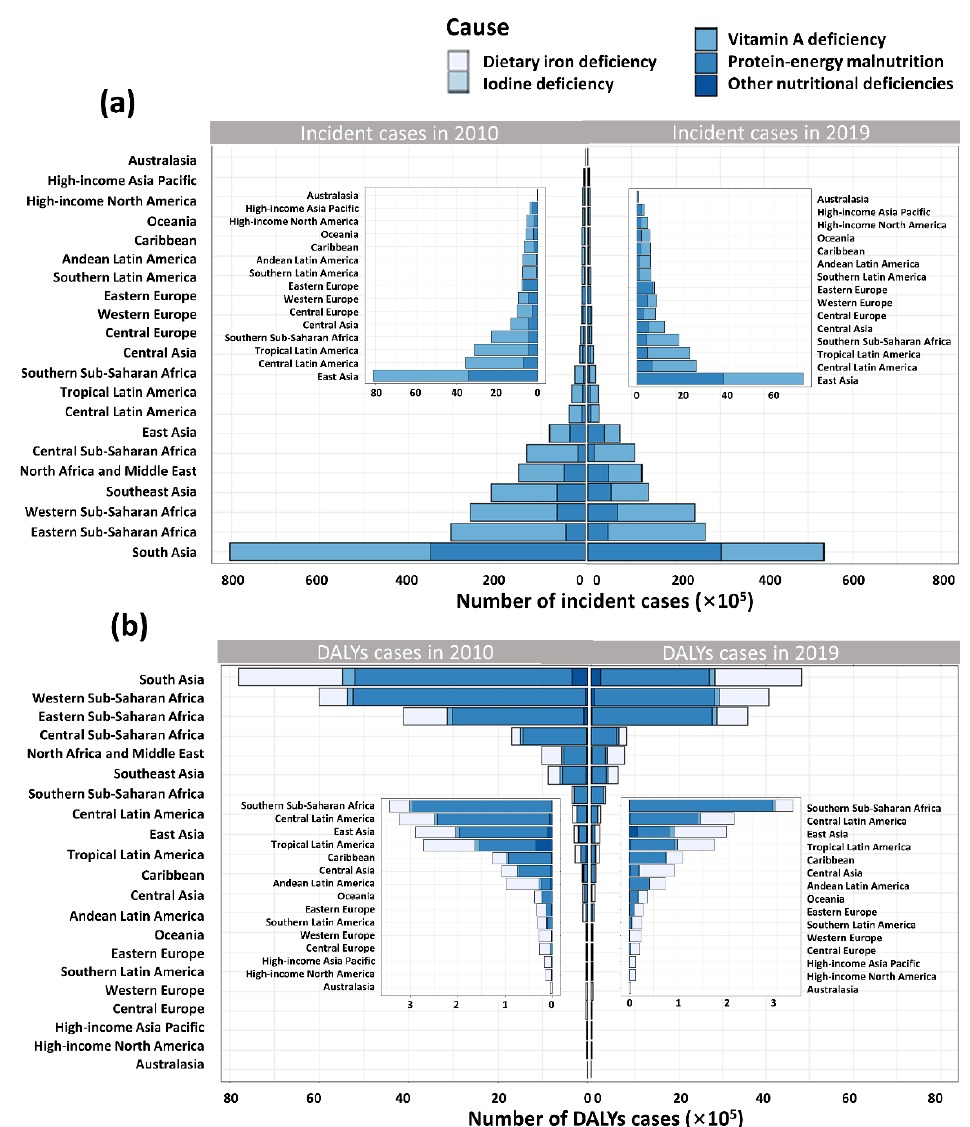
Figure 2. Nutritional deficiencies in children under 5 years of age caused by five different subcate- gories of nutritional deficiencies in 21 GBD regions. ( a ) Number of incident cases of five subcategories of nutritional deficiencies. ( b ) Number of DALYs cases of five subcategories of nutritional deficiencies.